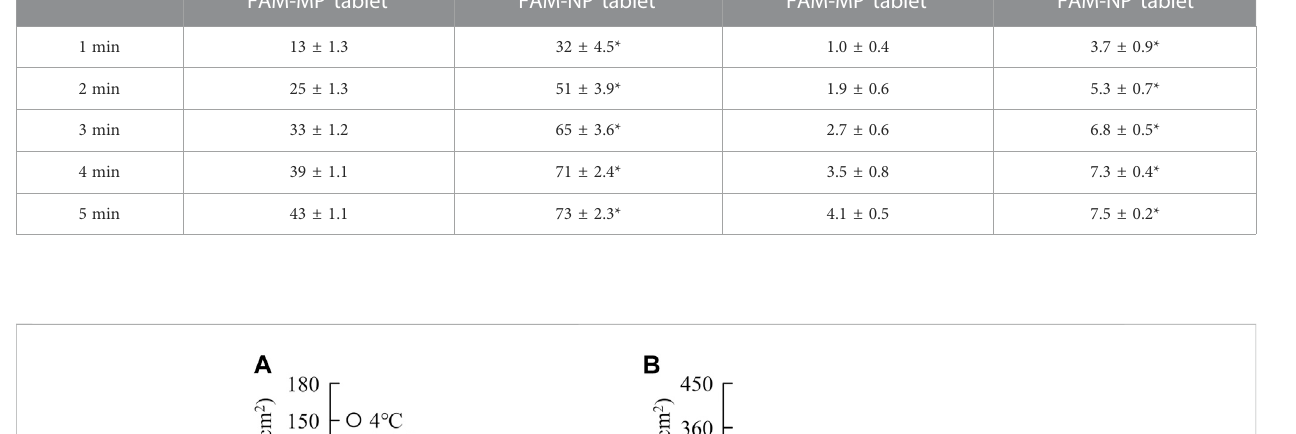
(Table 4; Figure 6). The plasma FAM levels and k a in rats administered the FAM-NP tablet were higher than those in rats